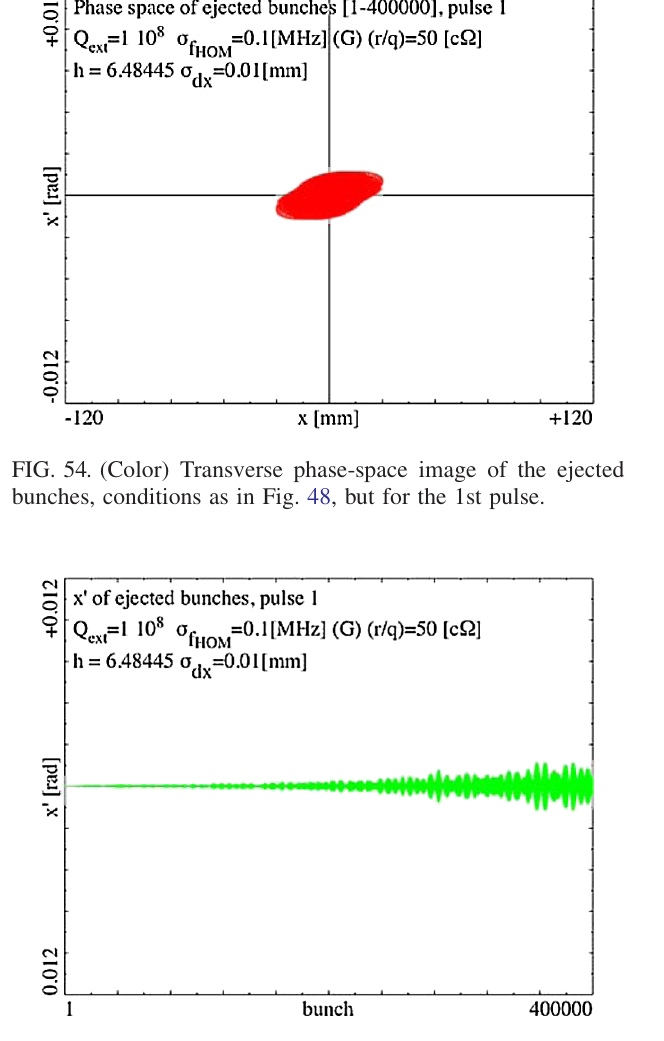
FIG. 55. (Color) x 0 [rad] corresponding to Fig. 54 (1st pulse).